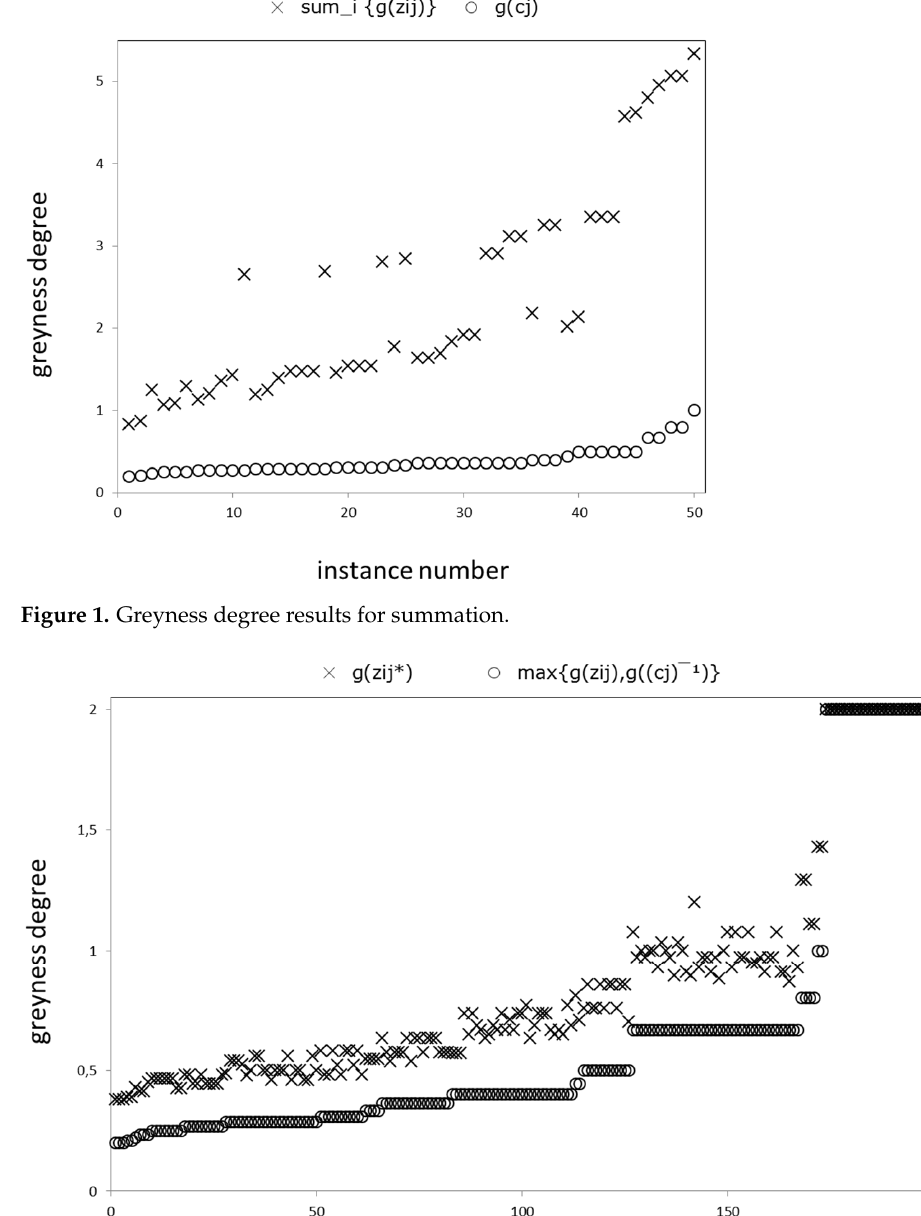
Figure 3. Greyness degree results for convex combination. 7. Illustration of Information Content Results: A Dice ‐ Rolling Experiment In this section we illustrate our arguments that relate to information content with the aid of a dice ‐ rolling experiment. For this purpose, consider an unusual yet fair 8 ‐ faceted die illustrated in Figure 4. In this experiment, the observer rolls the die once, and notes the number that shows up on the top facet of the die.